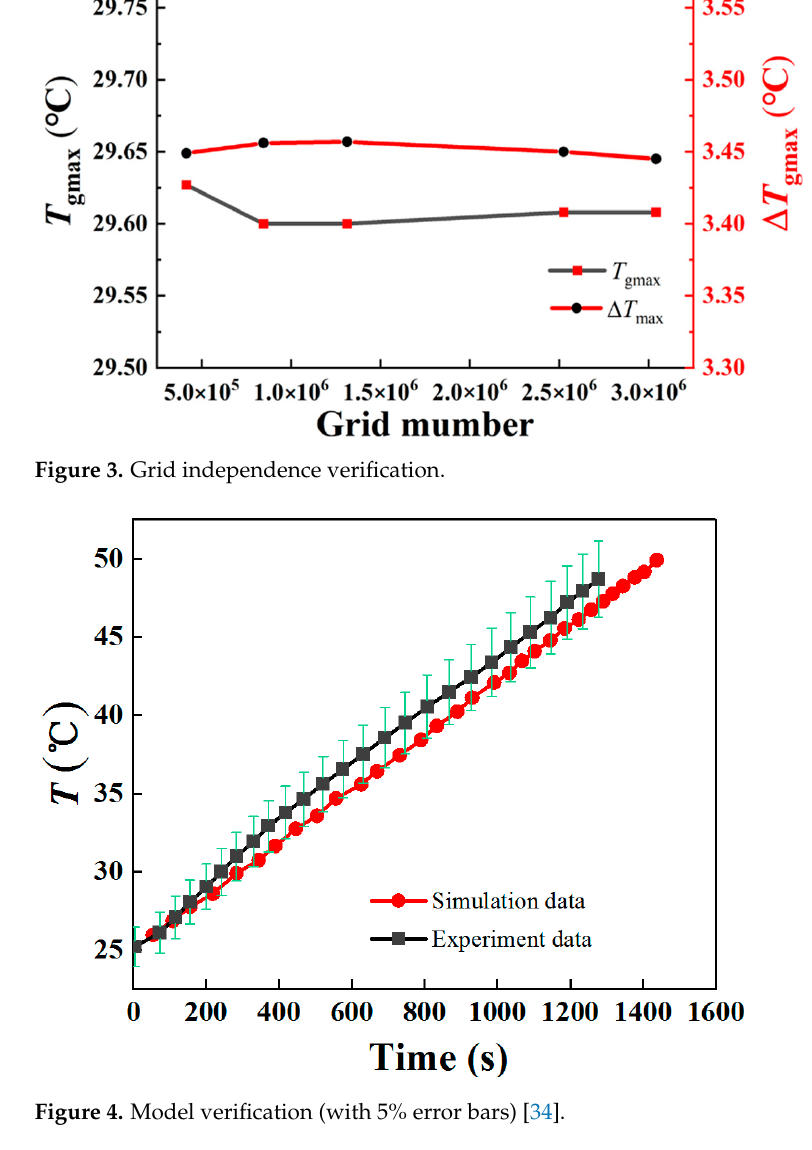
Figure 4. Model verification (with 5% error bars) [34]. 3. Results and Discussion 3.1. Wavy-Channel Design Figure 5 shows the temperature distribution of the battery module. It is obvious that the temperature distributions of the two designs are similar. The lowest temperature is located at the bottom of battery 1 near the coolant inlet, and the highest temperature ap- pears at the top of battery 12 near the coolant outlet. In addition, the maximum battery module temperature T gmax for the wavy-channel design is 29.61 °C, a reduction of 1.75 °C compared to the straight-channel design. The reason is that, on the one hand, the wavy channel increases the heat transfer area between the coolant and the cold plate, which in turn enhances the cooling performance of the cold plate. On the other hand, as shown in Figure 6, it is difficult to transfer heat to the center of the straight channel due to the large heat resistance of the boundary layer. For the wavy channel, when the coolant flows along the channel, the secondary flow (Dean vortex) is generated due to the centrifugal force,